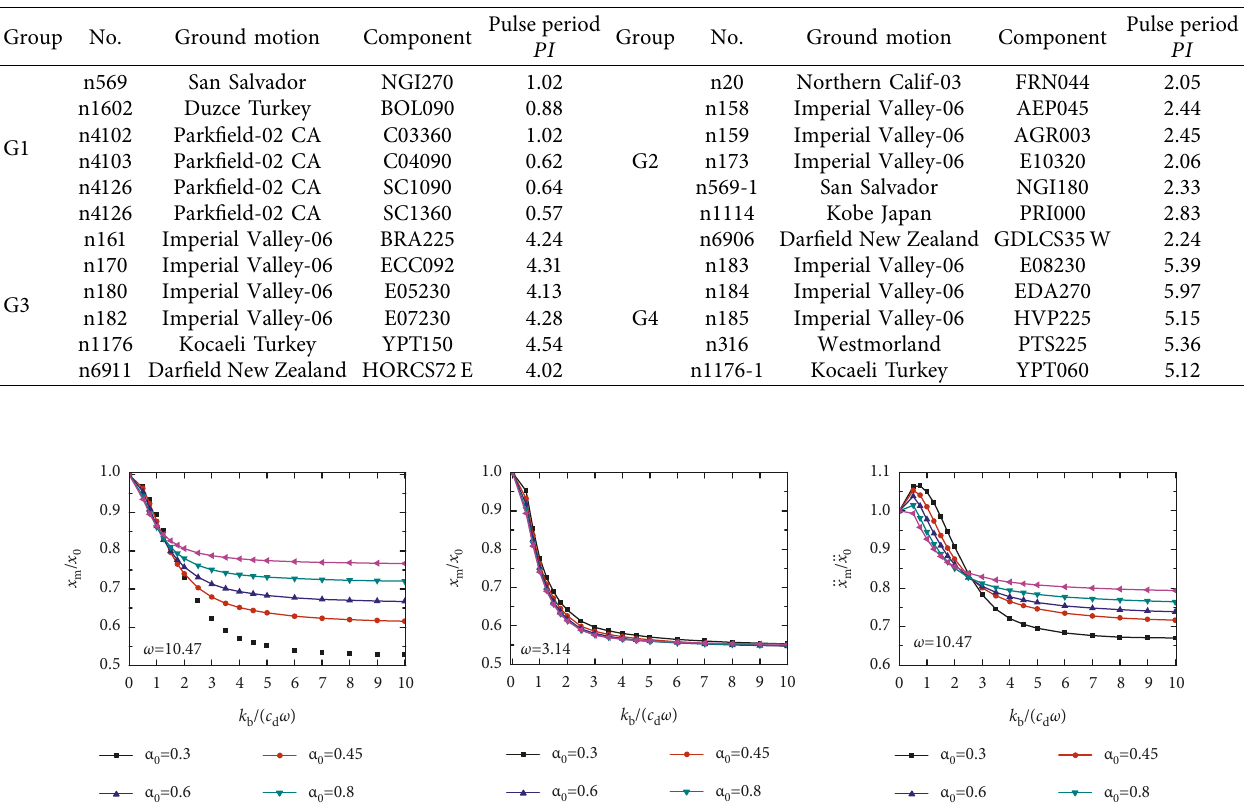
Table 1: Near-field pulse-type ground motions.